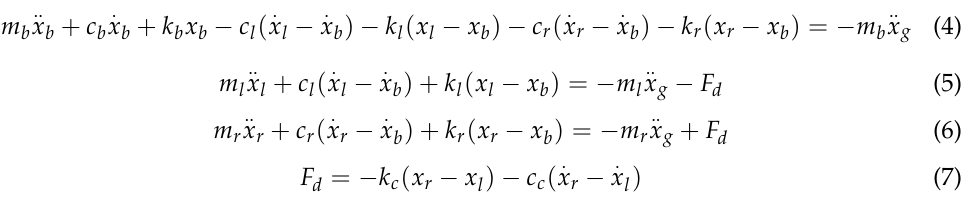
Figure 3. Deducing process